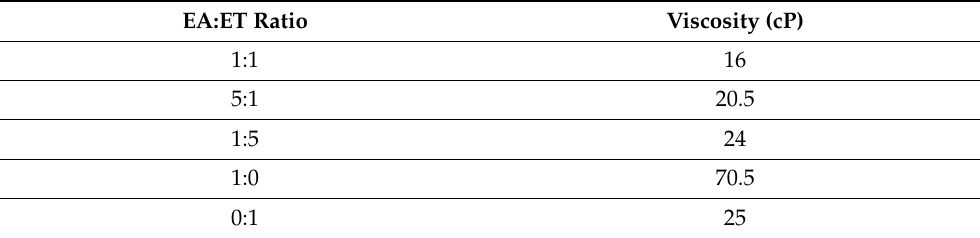
Table 3. Organic phase ethyl cellulose (EC) mixture viscosities.